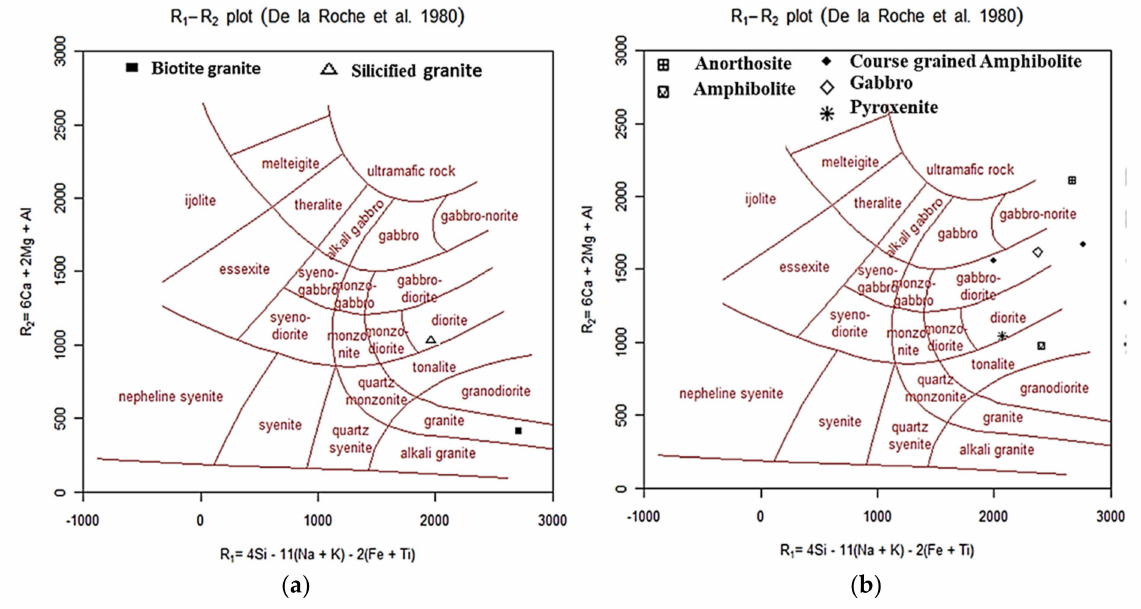
Figure 8. ( a ) Data plotted on R1-R2 plot [15] of granitoid rock. ( b ) Data plotted on R1-R2 plot [15] of the mafic-ultramafic